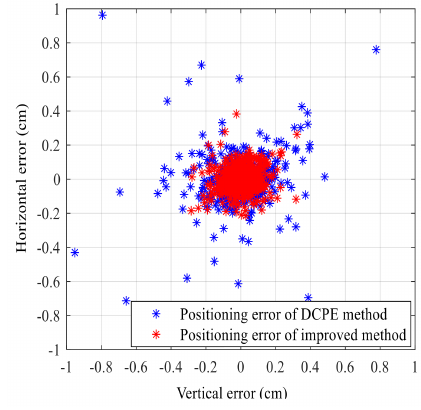
Figure 7. Comparison of positioning